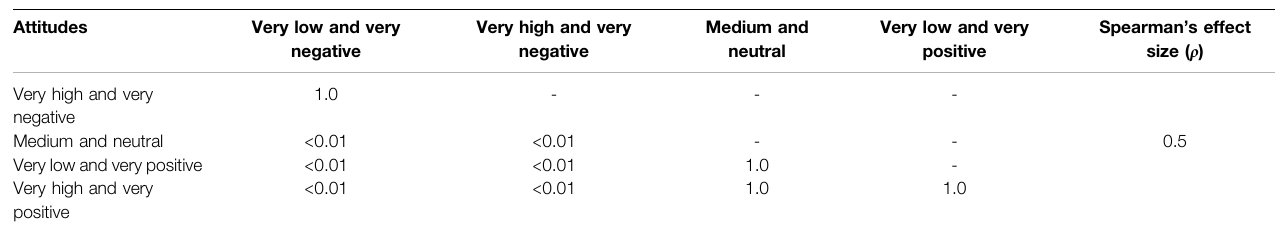
TABLE 4 | Wilcoxon ’ s Pairwise Tests, numbers are p -values from each tests, the attitudes are on both sides of the table with the Spearman ’ s effect size for the valence and then the arousal.